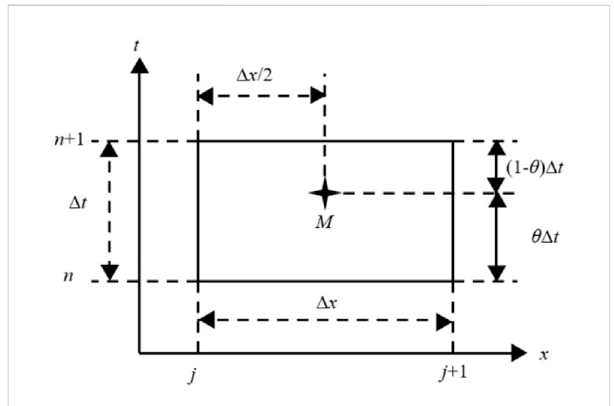
FIGURE 3 Schematic diagram of Preissmann four-point eccentric